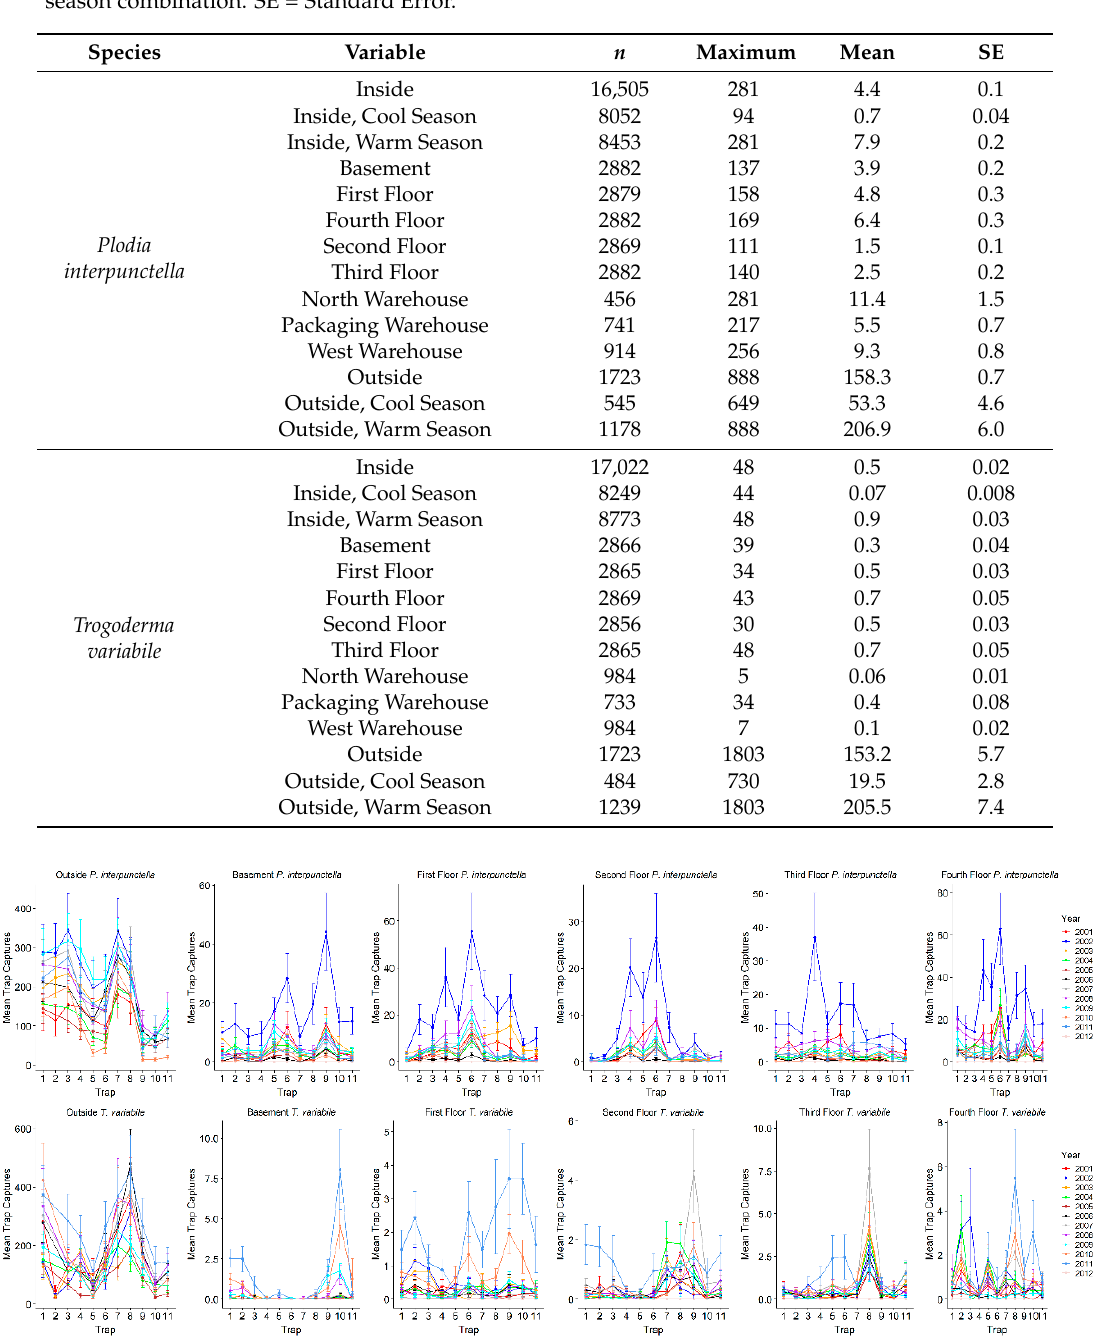
Table 2. Counts with maximum and mean for overall inside/outside numbers, inside/outside during cool season and inside/outside during warm season. Minimum values were 0 for each location and season combination. SE = Standard Error.